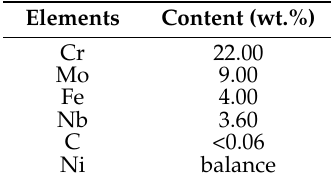
Table 2. Composition of the bond-coat material Nibasit 625-P. Data from DEW, Krefeld, Germany.